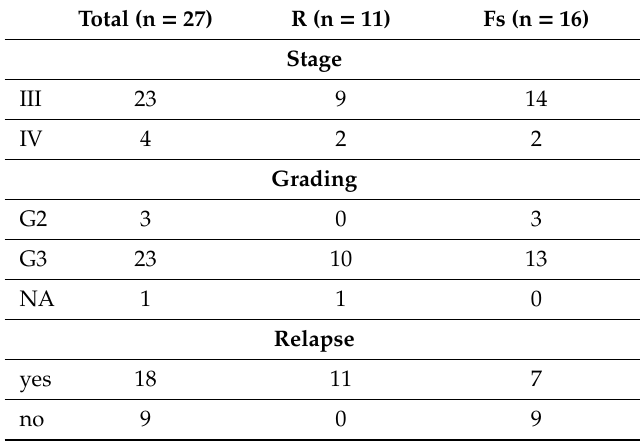
Table1. ClinicalcharacteristicsofTheCancerGenomeAtlas(TCGA)ovarianserouscystadenocarcinoma (TCGA-OV) 27